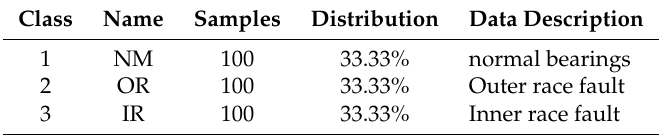
Table 1. Class distribution and description of the Intelligent Maintenance Systems (IMS) dataset.